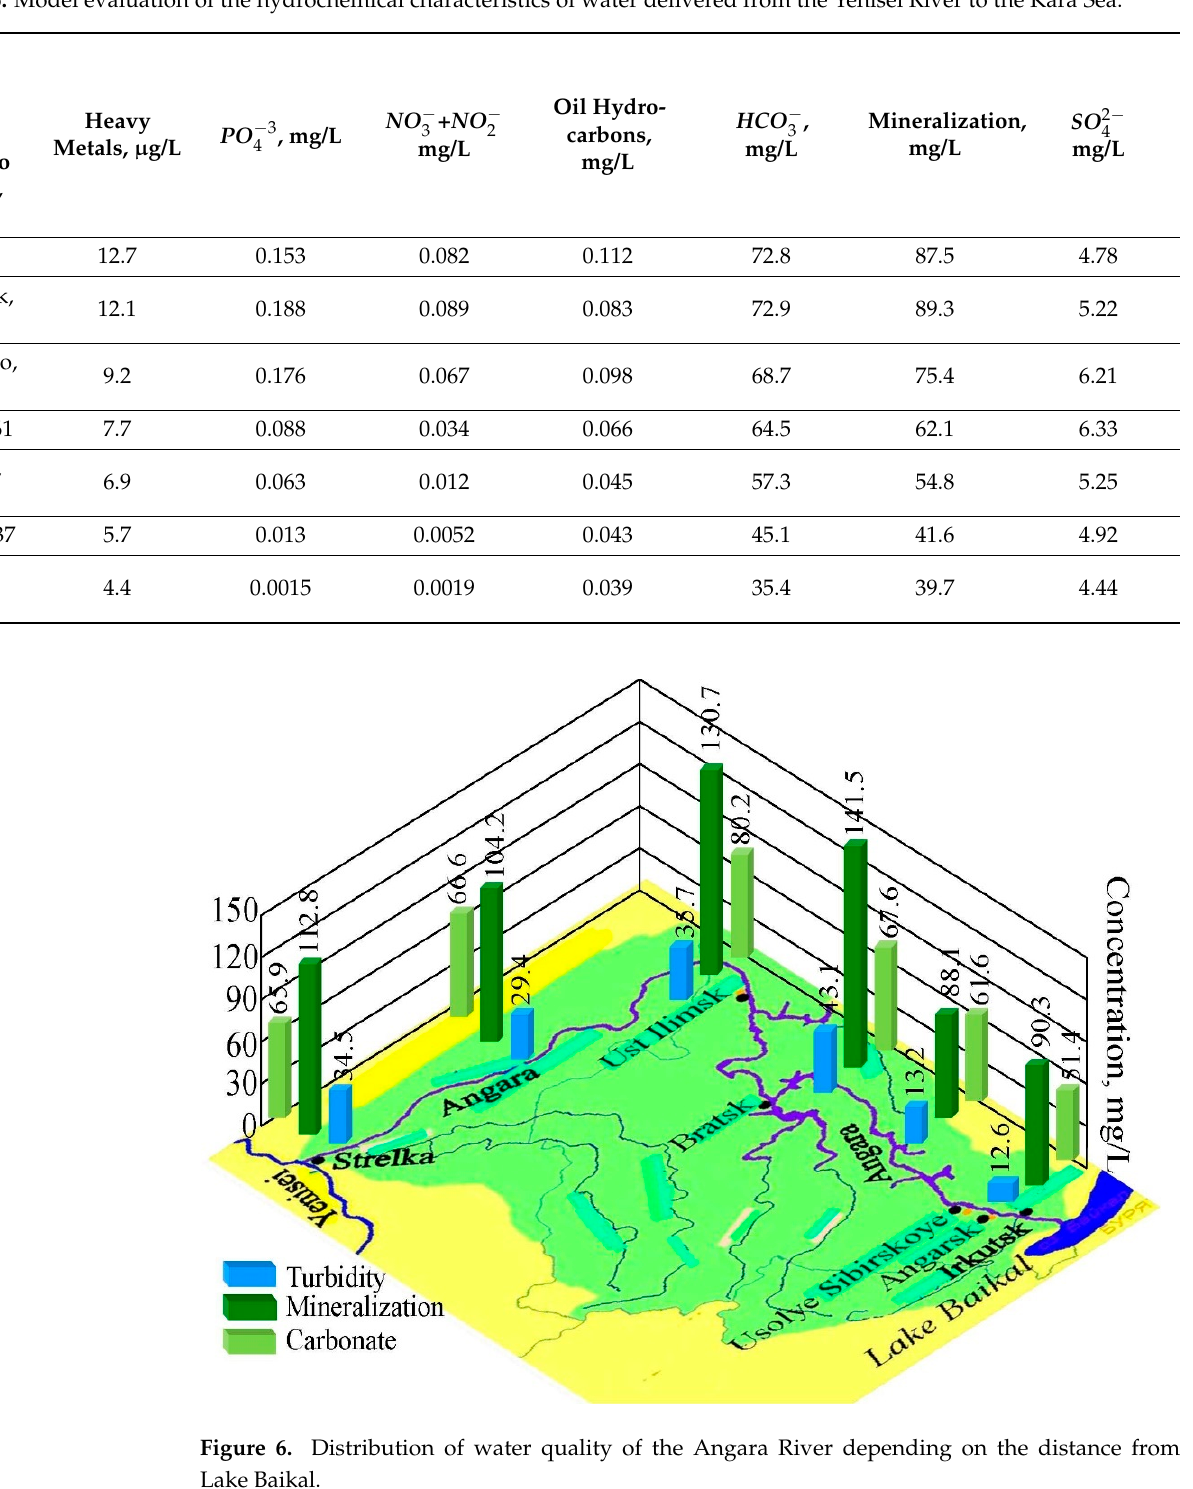
Figure 6. Distribution of water quality of the Angara River depending on the distance from Lake Baikal.